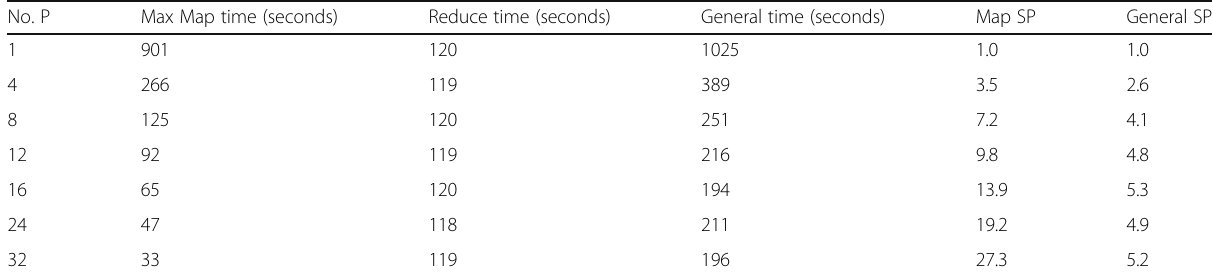
Table 4 The test results of a 4-GB file on different cores No. P Max Map time (seconds) Reduce time